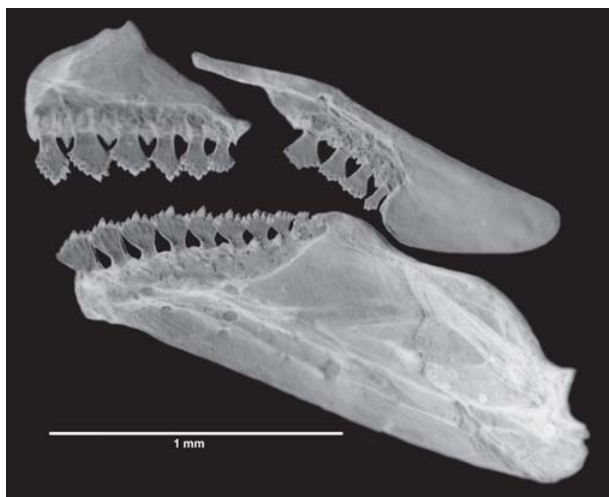
Fig. 24. Dentition of Odontostilbe pao , MCNG 54107, male 28.8 mm SL c&s. Photograph of left side premaxilla (top), max- illa (middle), and dentary (bottom), lateral view, under este- reosmicroscope.